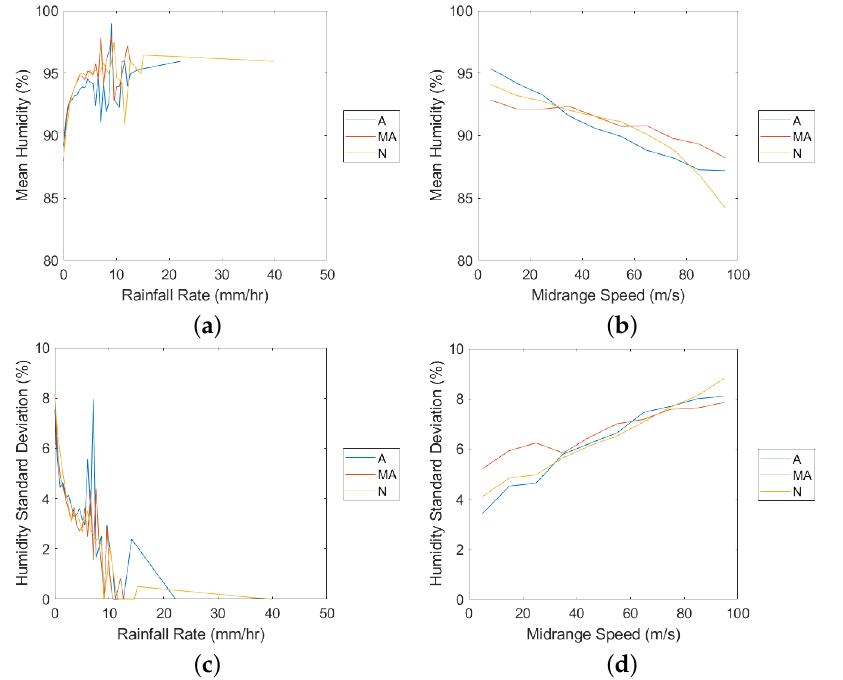
Figure 21. Means ( a , b ) and standard deviations ( c , d ) of data presented in Figure 20 against the midrange tip speed of each bin, for the respective stations.